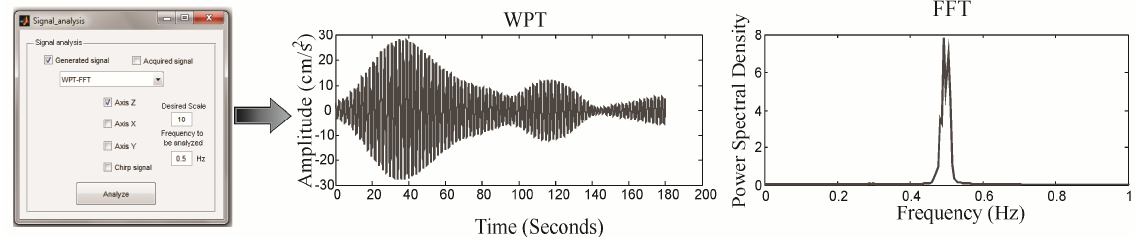
Fig. 5. Analyzer module.